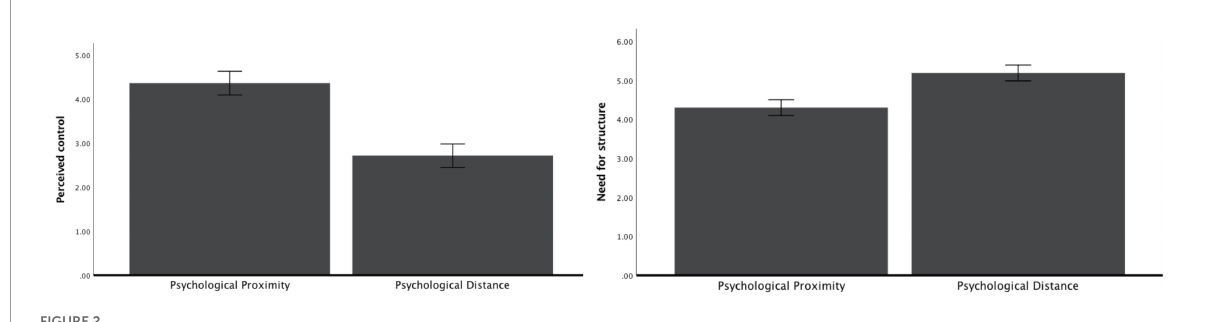
FIGURE2 Perceived control and need for structure as a function of psychological distance (study 1a).